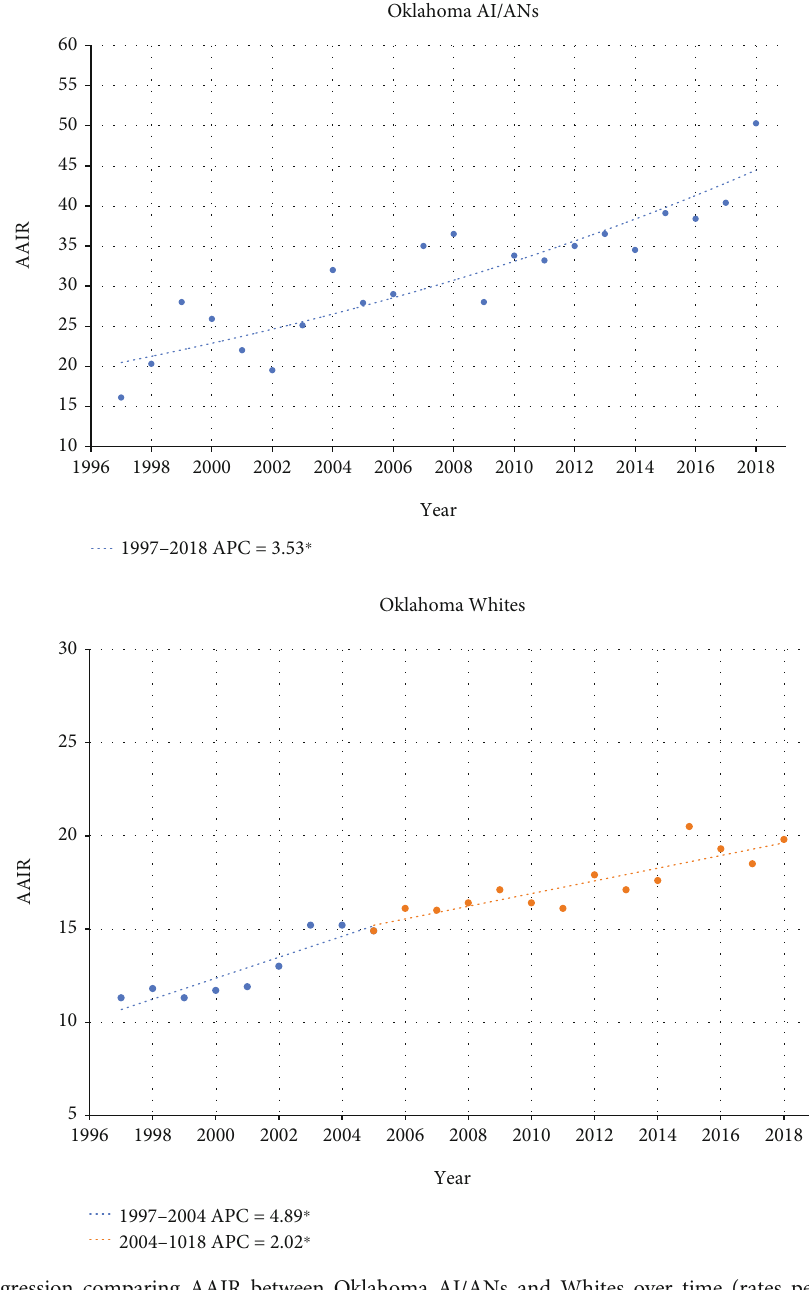
Figure 1: Joinpoint regression comparing AAIR between Oklahoma AI/ANs and Whites over time (rates per 100,000 population). ∗ Indicates that the annual percentage change (APC) is signi fi cantly di ff erent from zero at the alpha = 0 : 05